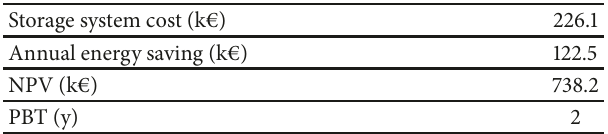
Table 4: Economic benefit